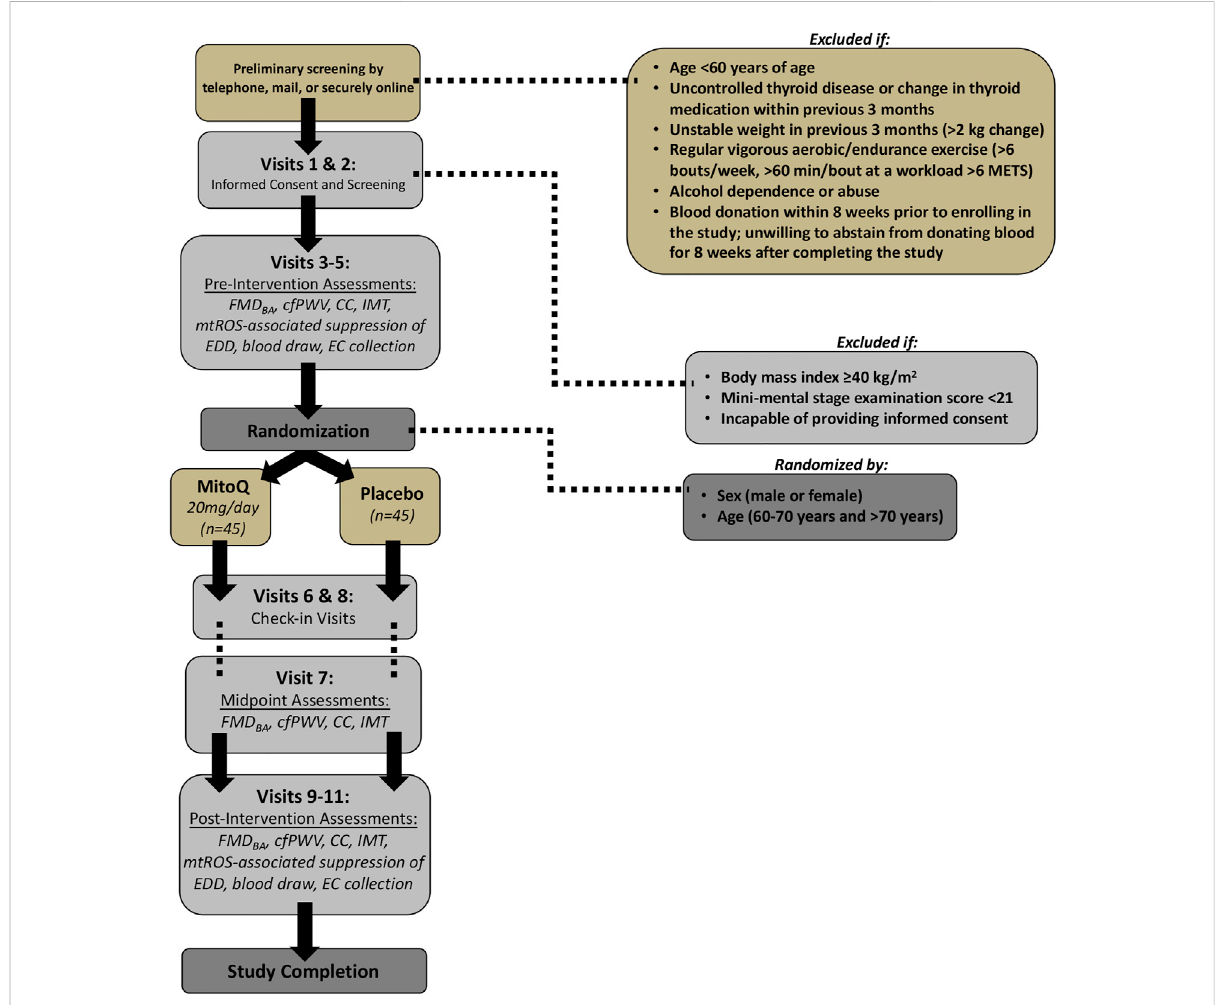
FIGURE 2 Study Design. FMD BA = brachial artery fl ow-mediated dilation; cfPWV = carotid-femoral pulse wave velocity; CC = carotid (artery) compliance; IMT= (carotid artery)intima media thickness; EC = endothelial cell; METs = metabolic equivalents; mtROS= mitochondrial reactiveoxygen species; EDD = endothelium-dependent